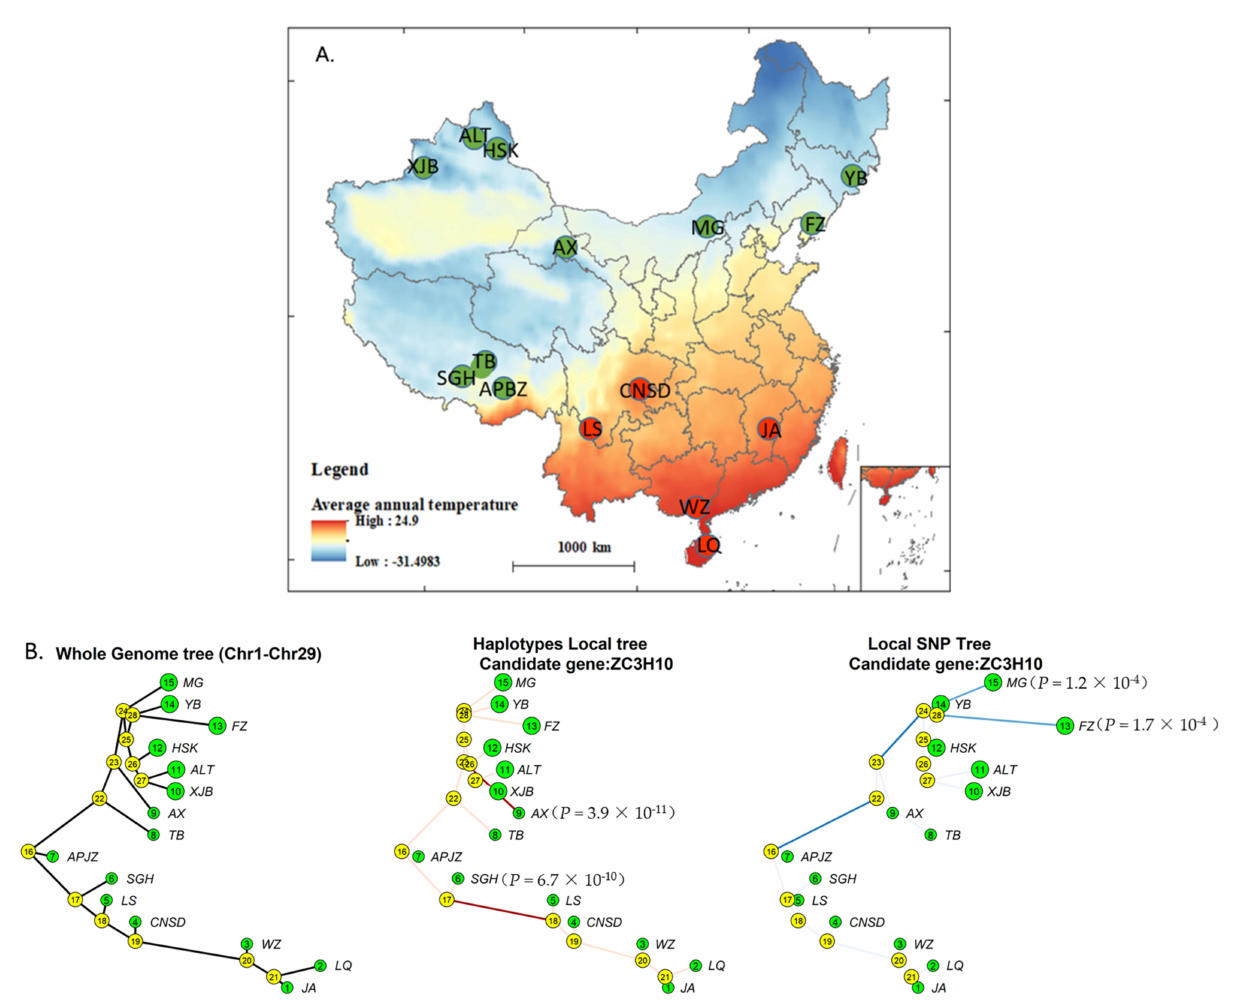
Figure 1. Distribution and selective signature of 15 cattle breeds. ( A ) Distribution of sampling cattle breed. Green circles represent the cold-adapted group, red circles indicate the heat-adapted group. ( B ) Local trees of the bovine ZC3H10 from the FLK and hapFLK analyses. The p value represents the significance of selection